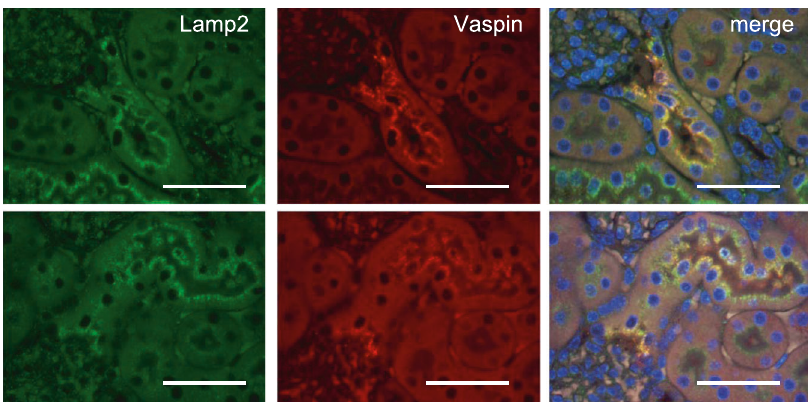
Fig. 8 Internalization of rhVaspin into proximal tubular cells in vitro. rVaspin was intraperitoneally injected into Vaspin − / − mice. After 30 min, kidney samples were collected, and subjected to immuno fl uorescence study. rhVaspin (red) was internalized into proximal tubular cells and co-localized with Lamp2 (green). Bar = 100 μ m. Immunostaining experiments were repeated twice.